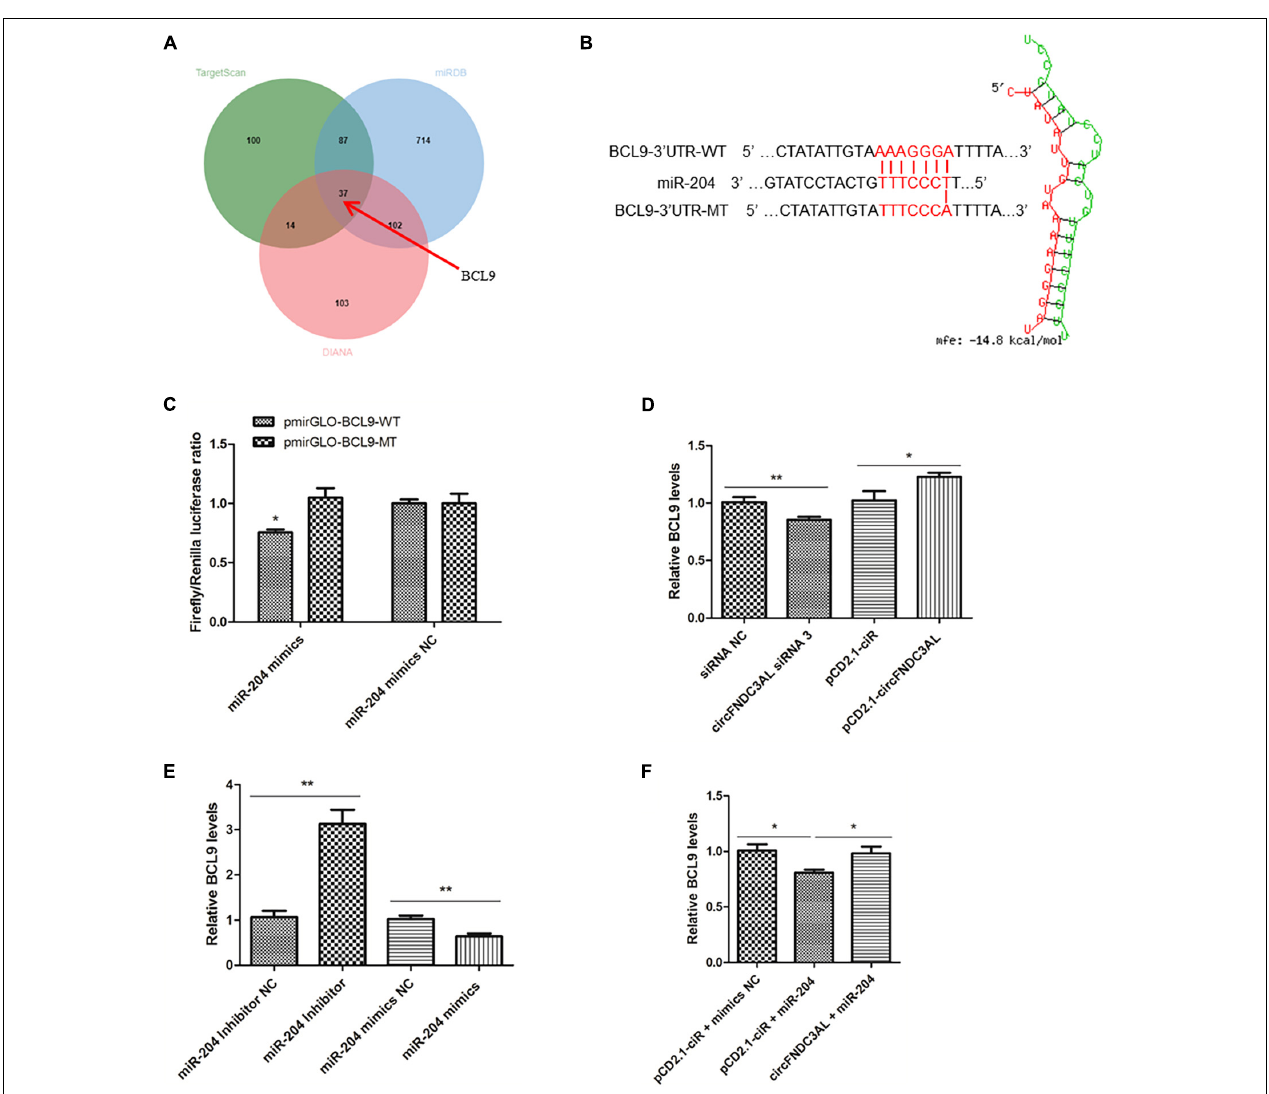
FIGURE 7 | BCL9 is a target gene of miR-204 and circFNDC3AL relieves BCL9 from the inhibition of miR-204. (A) The target genes of miR-204 were analyzed using TargetScan, miRDB and Diana softwares. (B) Binding site of BCL9 3 (cid:48) UTR and miR-204 was predicted using RNAhybrid, and the wild type or mutant type of miR-204 targeting site designed for luciferase reporter assays. (C) Firefly/Renilla luciferase ratio was detected after DF-1 cells were transfected with pmirGLO-circ FNDC3AL-WT/pmirGLO-circFNDC3AL-MT or miR-204 mimics/mimics NC. (D) Expression levels of BCL9 were determined using qPCR after SMSCs were transfected with circFNDC3AL siRNA or overexpression plasmid. (E) Expression levels of BCL9 were determined using qPCR after SMSCs were transfected with miR-204 inhibitor or mimics. (F) Expression levels of BCL9 were determined using qPCR after SMSCs were co-transfected with pCD2.1-circFNDC3AL/pCD2.1-ciR and miR-204 mimics/mimics NC. Values represent as means ± S.E.M. of three biological replicates. * P < 0.05; ** P <